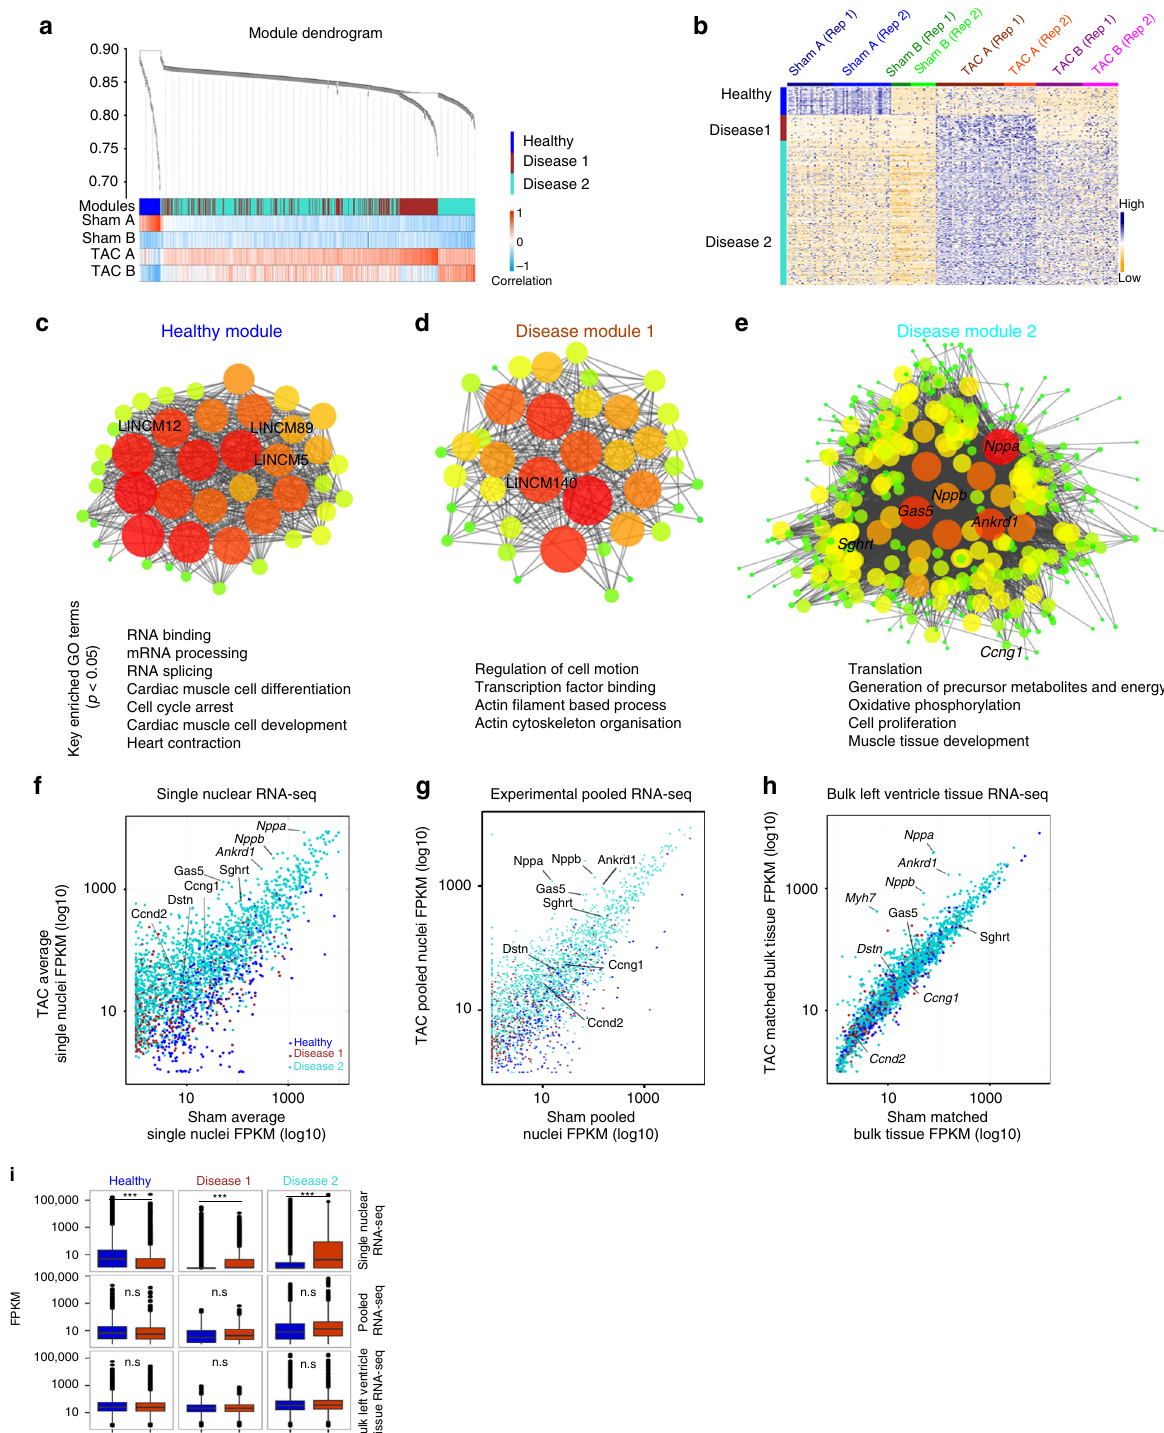
Fig. 2 LincRNAs in nodal hubs of gene regulatory networks. a , b WGCNA identi fi es three distinct gene modules (Healthy, Disease 1 and Disease 2) ( a ) in Sham and TAC nuclei that represent expression signatures of speci fi c Sham or TAC nuclear subgroups ( b ). c – e WGCNA reveals candidate lincRNAs in nodal hubs bearing the highest connectivity with other genes within the gene regulatory network modules. Gas5 and Sghrt are in nodal hubs within disease module 2 ( e ) and highly correlated with expression of other genes in the network such as Nppa , Dstn , Ccng1 , and Ccnd2 . Size and color of bubbles represent strength and signi fi cance of connectivity. Key enriched gene ontology (GO) terms are listed for each module ( p < 0.05 Fisher ’ s exact test). f – h Scatterplots showing the expression of genes from the 3 gene modules at the single-nuclear level ( f ), at pooled nuclei level ( g ) and matched bulk left ventricle tissue RNA-seq ( h ). i Signi fi cant differential expression of genes from the three gene modules between Sham and TAC samples is detected only by single nuclear RNA-seq, and not by pooled nuclei or bulk tissue